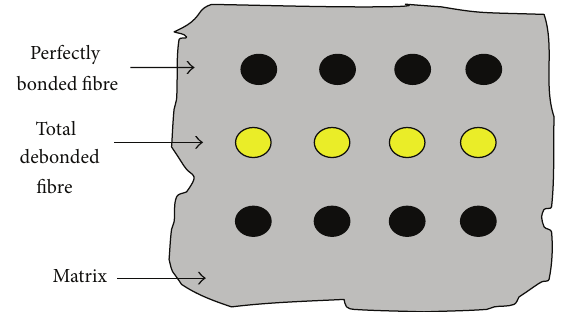
Figure 3: Concept of square unit cell for aligned pattern of composite with alternate layers of debonded fibres.